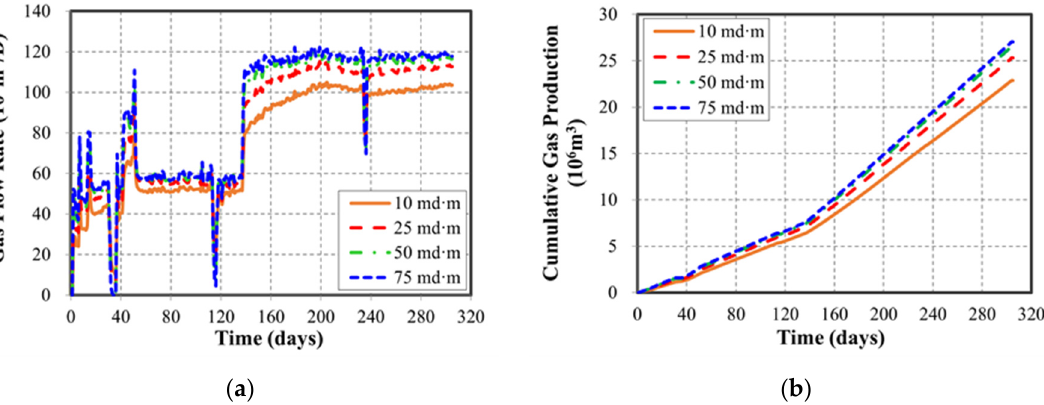
Figure 7. Production with different initial hydraulic fracture conductivity values: ( a ) gas flow rate; ( b ) cumulative gas production.